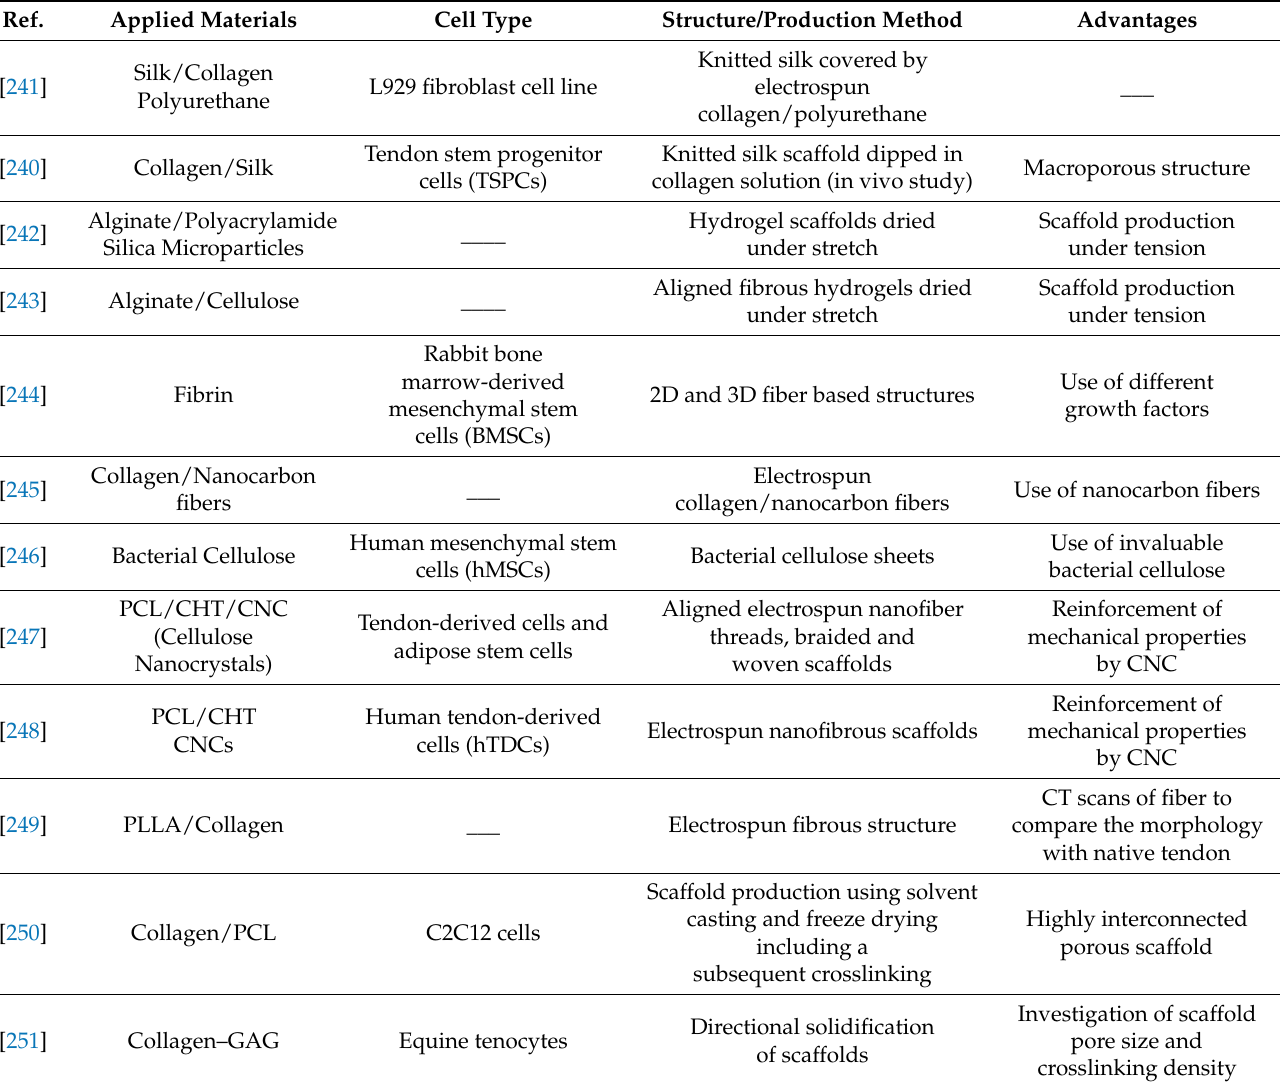
Table 4. Summary of recent studies using natural polymers in tendon/ligament tissue engineering.